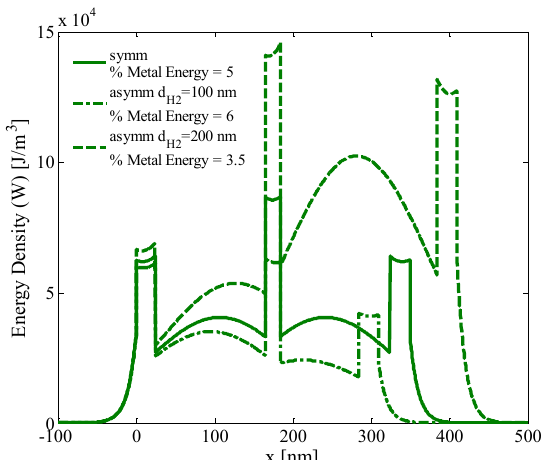
Figure 10: Energy Density of the TM 1s fundamental mode at the cross-section of HMIM slab waveguide with d L =25 nm, for: 1. symmetrical case with d H =140 nm, 2. asymmetrical case with d H1 =140 nm and d H2 =100 nm, and 3. asymmetrical case with d H1 =140 nm and d H2 =200 nm. Percentage of energy in metal layer is also included for comparison.